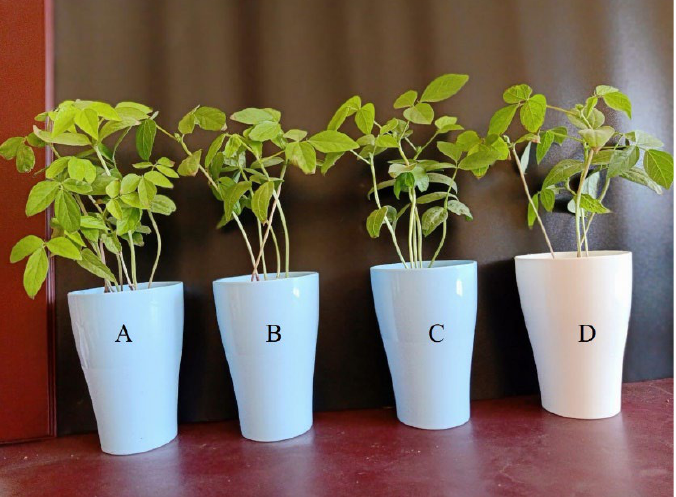
Figure 2. The impact of MgONPs on the growth of mung bean seedlings: A: a concentration of 100 µg/mL; B: a concentration of 50 µg/mL; C: a concentration of 25 µg/mL; and D: only water.